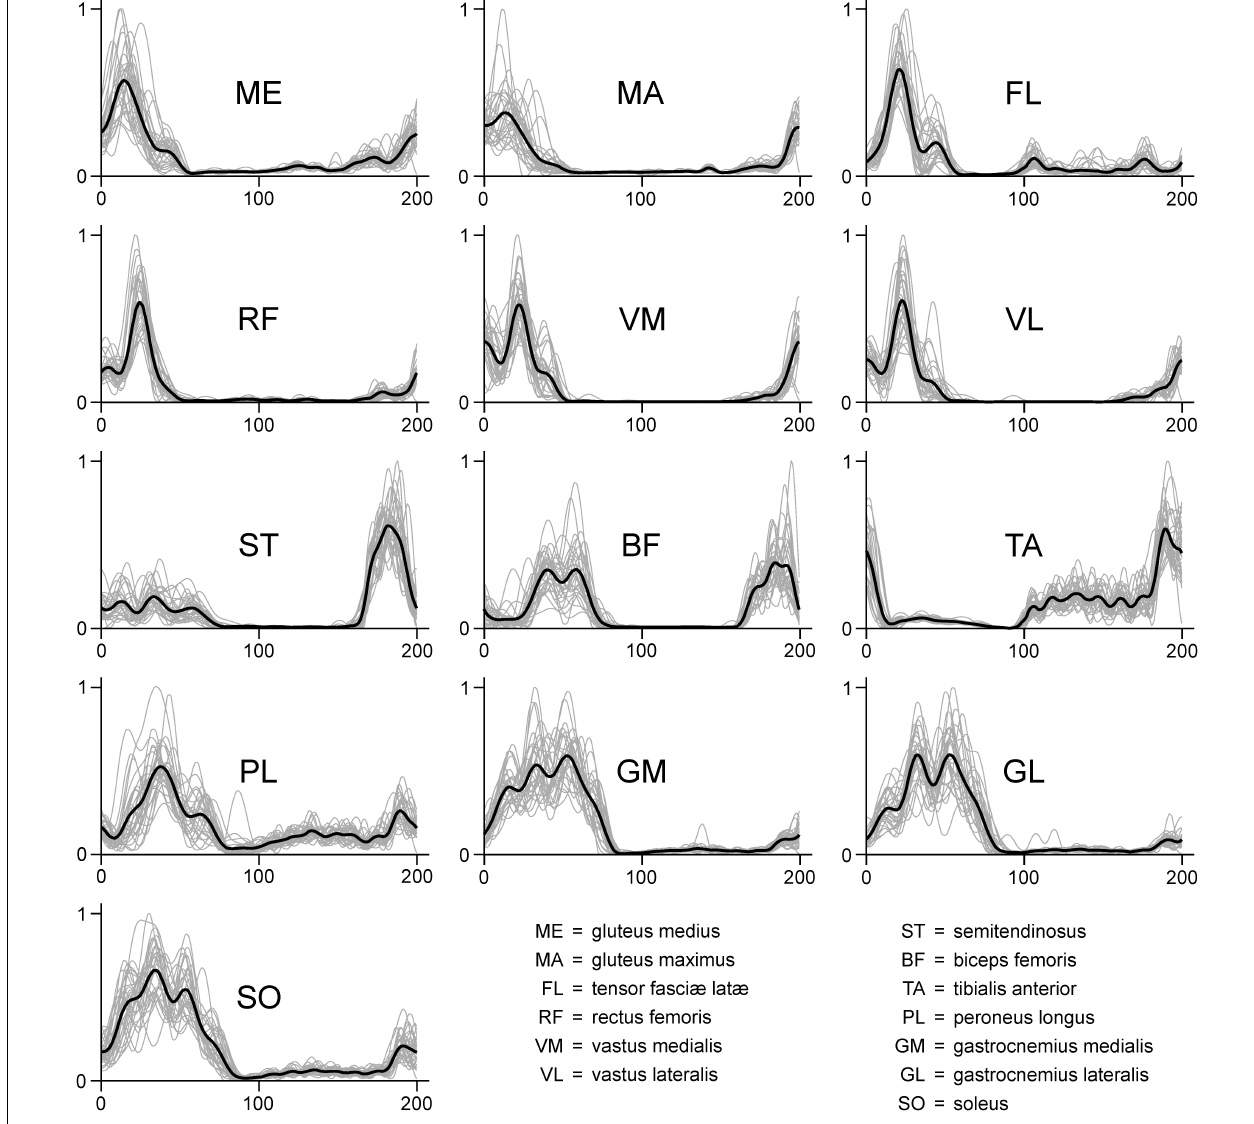
FIGURE 2 | Exemplary EMG activity of the 13 recorded muscles recorded for one participant during one trial (treadmill running). Signals were high-pass filtered (4th order IIR Butterworth zero-phase filter, cut-off frequency 50 Hz), full-wave rectified, low-pass filtered (4th order IIR Butterworth zero-phase filter, cut-off frequency 20 Hz) and normalized to the maximum (dimensionless y -axis units). Since each gait cycle was time-normalized to 200 points, in each graph the first 100 points on the x -axis represent the stance phase, while the second 100 points represent the